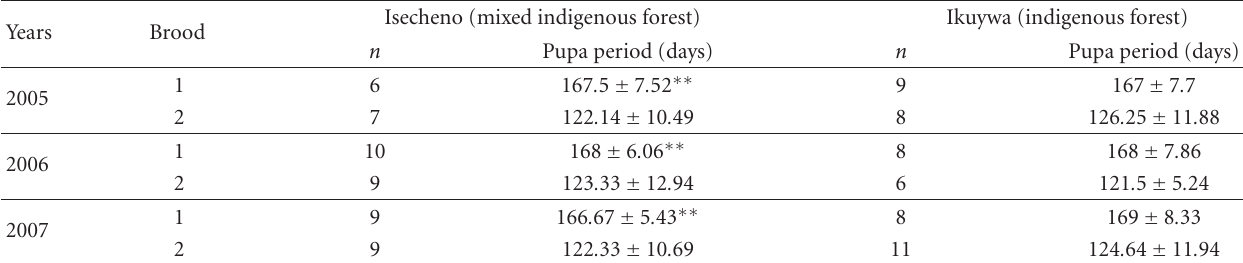
Table 2: Mean ( ± SD) pupal period (days) of A. panda in the Kakamega Forest. Isecheno (mixed indigenous Years Brood